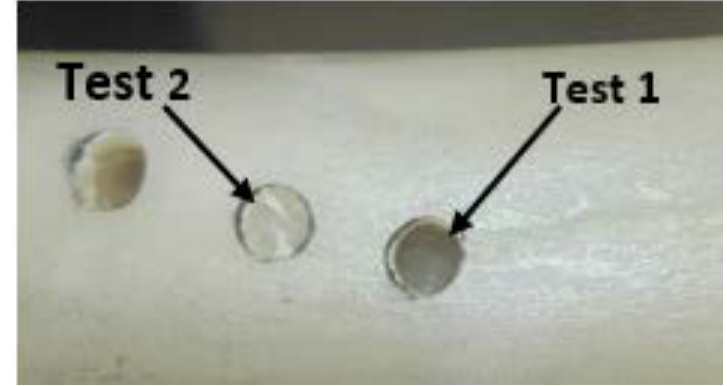
Figure 5: Effect of rotational speed on the temperature.